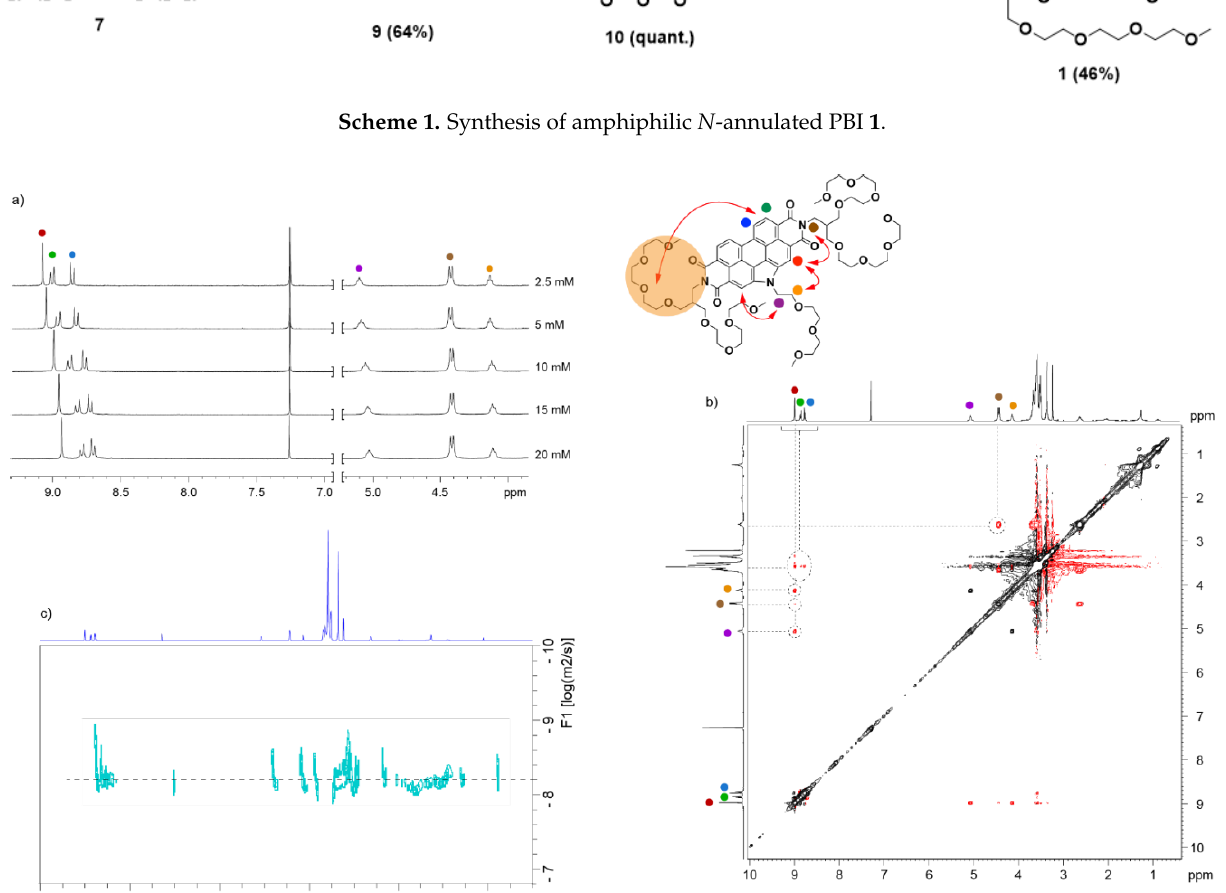
Figure 2. ( a ) Concentration-dependent 1 H NMR spectra of 1 (CDCl 3 , 300 MHz, 25 °C) showing the signals associated with the aromatic protons and to the methylene units linked to the nitrogen and oxygen atoms; ( b ) 2D-ROESY NMR spectrum (CDCl 3 , 300 MHz, 20 mM, 25 °C) of 1 . The circles highlight the intermolecular through-space coupling signals between the protons indicated by the curved arrows in the central illustration of 1 ; ( c ) partial 1 H DOSY NMR (Δ = 160 ms, t = 3 ms) spectra of 1 (20 mM, CDCl 3 , 25 °C, 300 MHz).